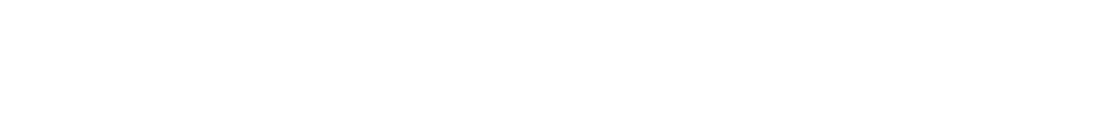
FIGURE 3 |Areas of significant activation in response to fearful expressions in right MTLE patients before and after lobectomy .The numbers at the bottom of each sagittal slice represent z -axis levels according toTalairach coordinates.The statistical threshold is set at p < 0.001 (uncorrected) with a spatial extension of at least four contiguous